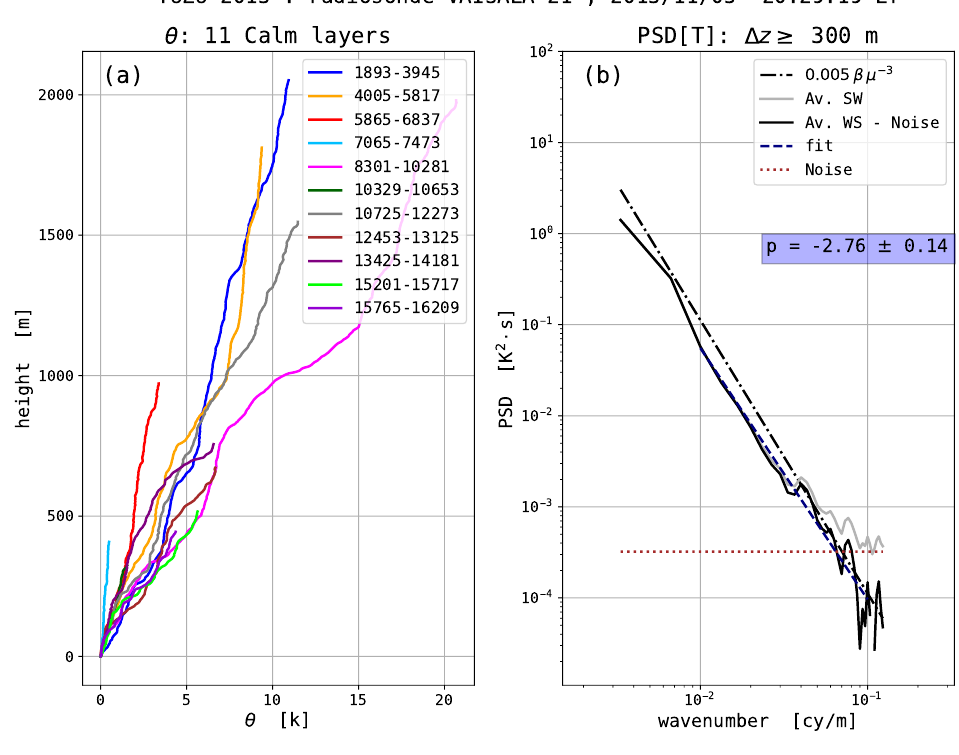
Figure 9. Same as Figure 8 but for the eleven stably-stratified layers of flight